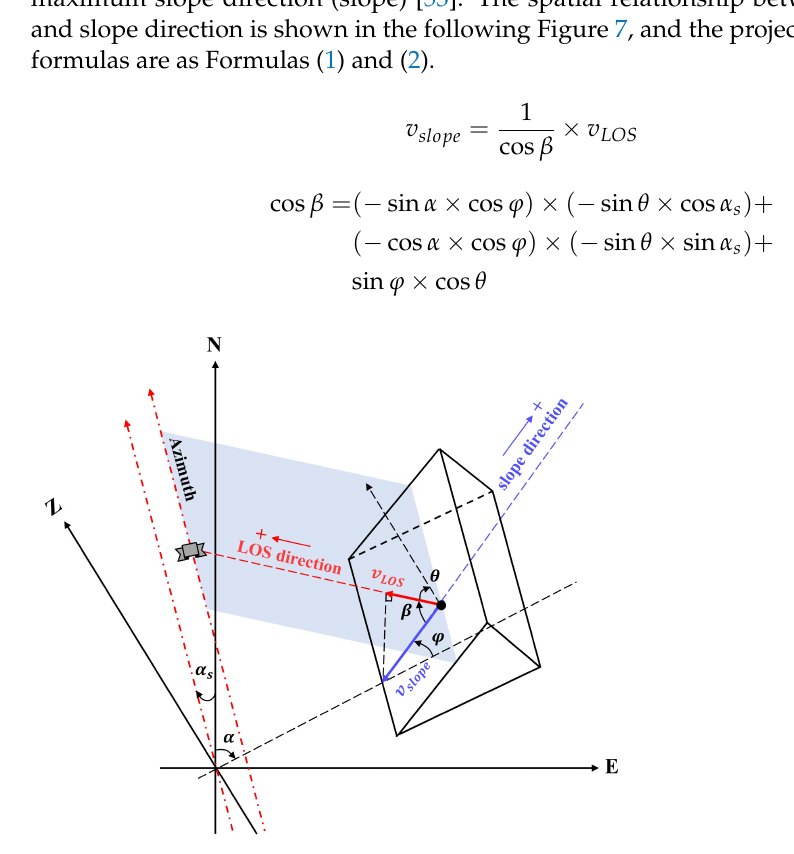
Figure 7. Spatial relationship between v slope and v LOS directions for a point (black dot) located on the slope. v slope is the deformation rate along the slope, v LOS is the deformation rate along the LOS direction. β is the angle between the v LOS and v slope directions, rotating from v slope to LOS direction. α is the aspect angle. ϕ is the slope angle. θ is the angle between the vertical direction and LOS, i.e., the incidence angle with reference to flat land. α s is the angle between the satellite azimuth and the true north direction, rotating from the north to ascending orbit direction in our study, and for the Sentinel-1A at orbit 172 is − 12 ◦